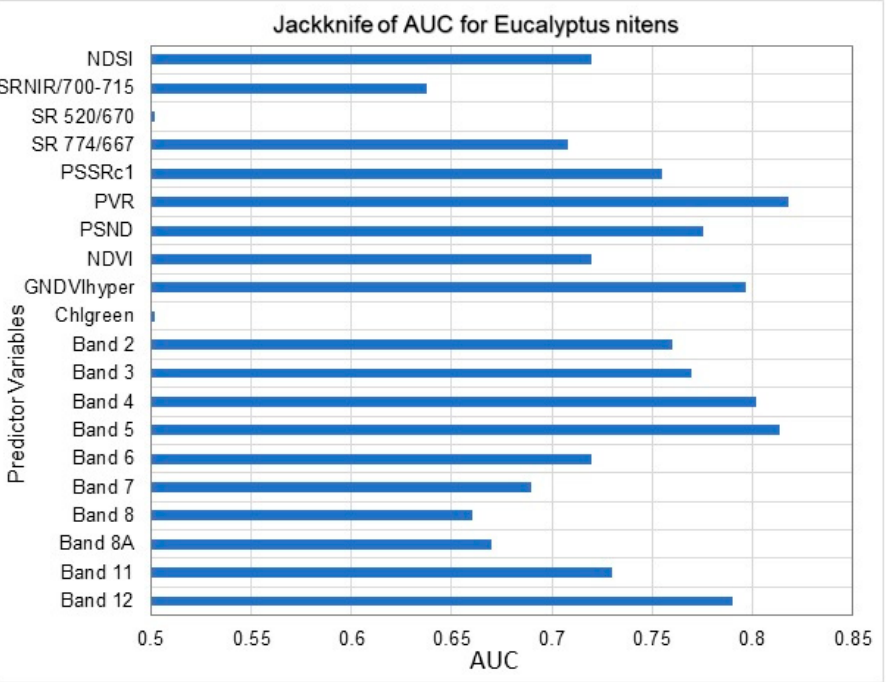
Figure 3. Jack-knife test variable importance graph of combined variables derived in modelling the spatial distribution of the C. tristis .